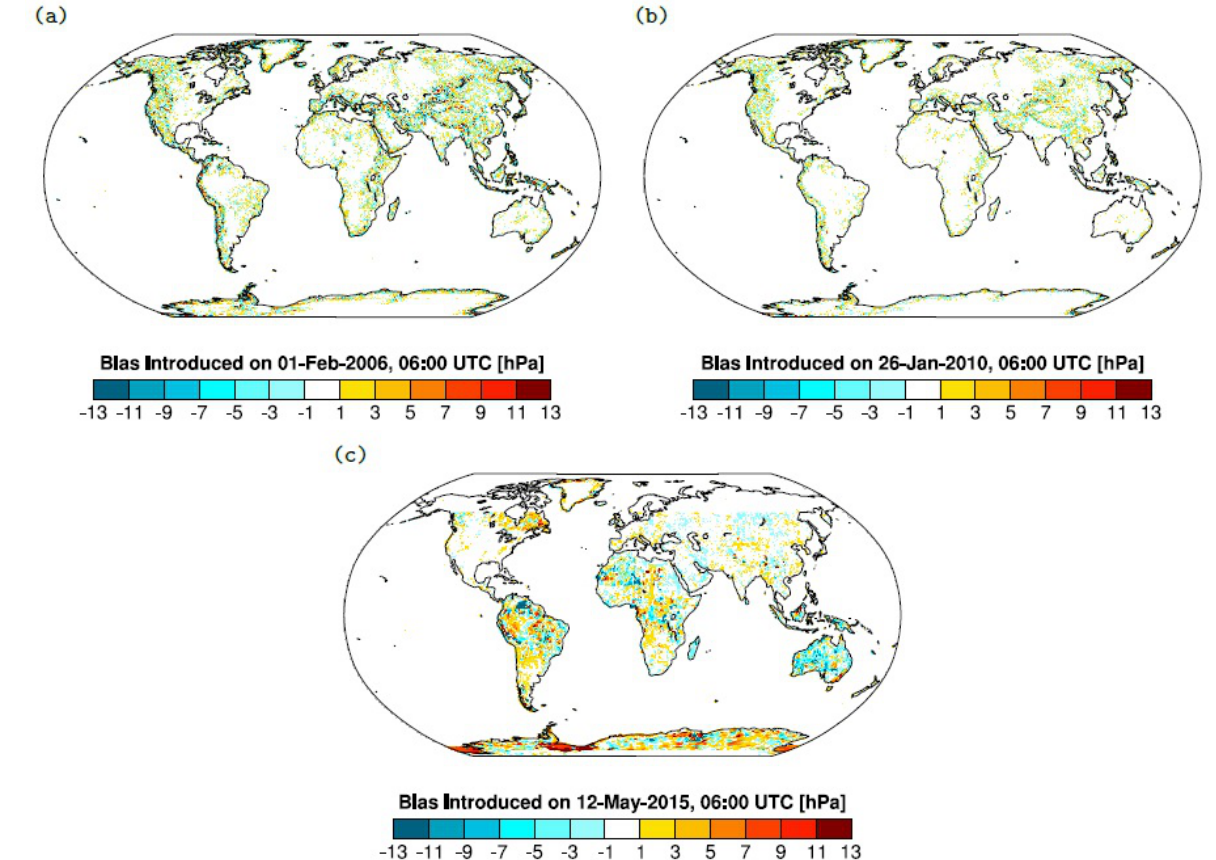
Figure 3: Biases introduced into the time series of surface pressure from the operational ECMWF analyses at a spatial resolution of 0.5 ∘ : (a) due to the change in resolution from T511 to T799 on February 1st, 2006, 06:00 UTC; (b) due to a further change in horizontal resolution to T1279 on January 26th, 2010, 06:00 UTC; and (c) due to the introduction of a fully revised model orography on May 12th, 2015, 06:00